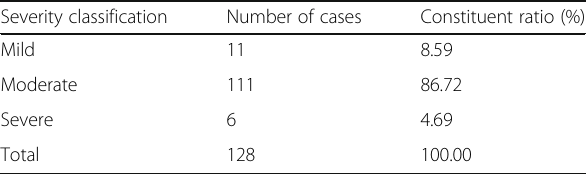
Table 7 The severity classification of ADR of XSTI Severity classification